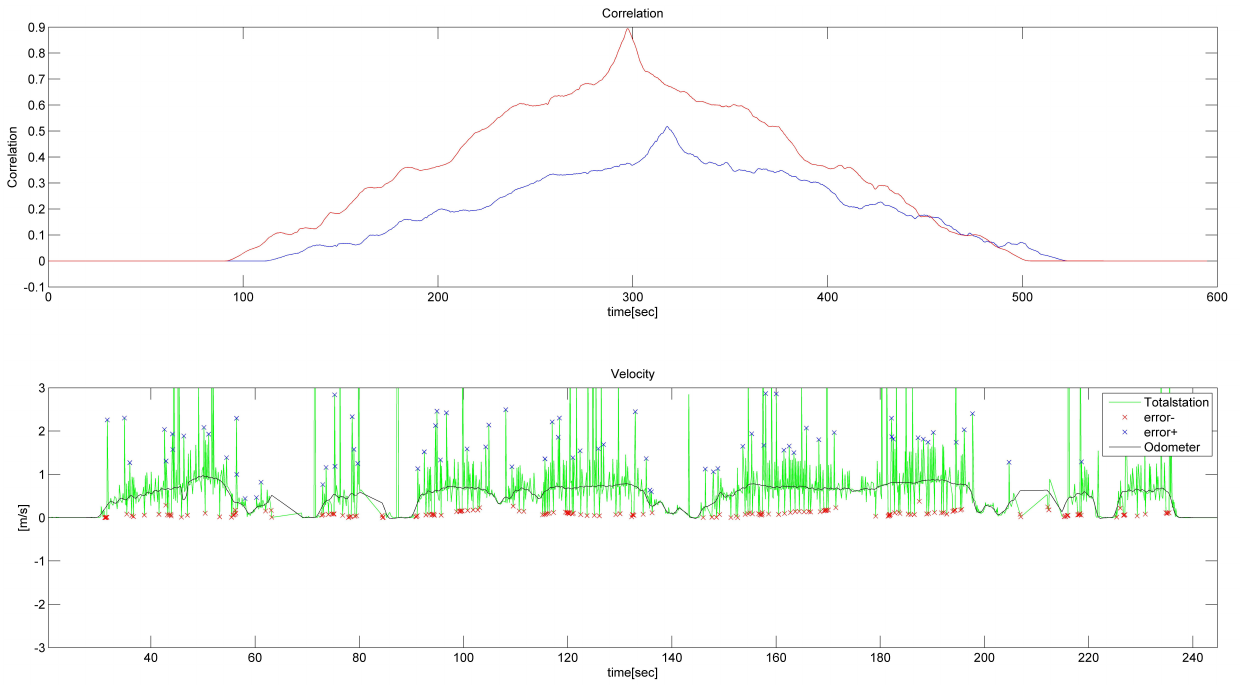
Figure 11. ( Top ) The correlation with outliers in blue and without outliers in red; ( Bottom ) The velocity profiles of trajectory 2; the odometer in blue and the total station in